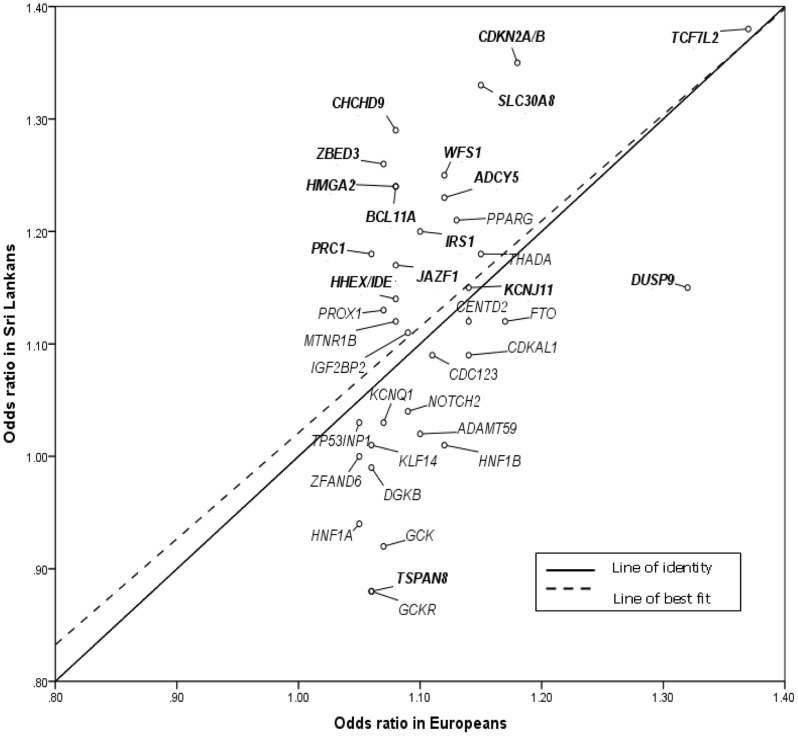
Comparison of allelic ORs between South Asians from Sri Lanka and Europeans.Loci labelled in bold are variants that showed nominal significance (p<0.05) in Sri Lankan subjects. European ORs used were derived from previously reported studies (Table S1).